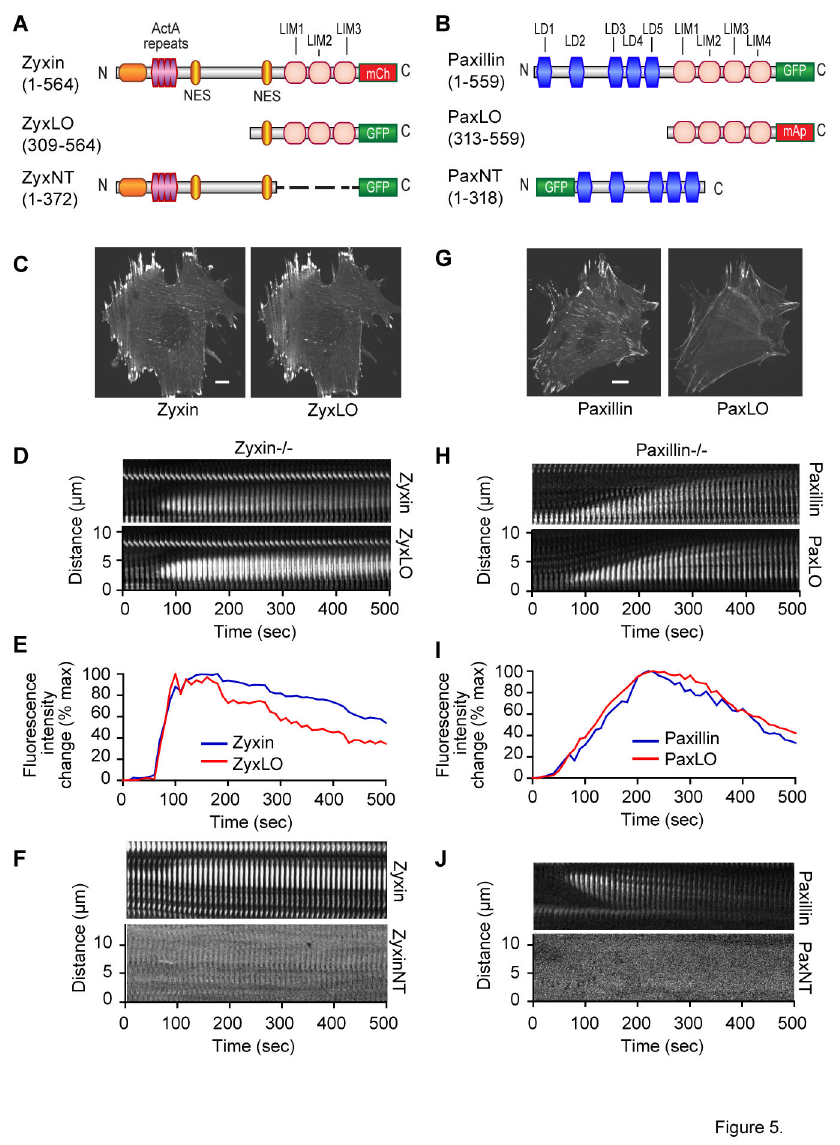
Figure 5. The LIM domains of paxillin and zyxin are necessary and sufficient for recruitment to SFSS. We generated GFP tagged truncated zyxin, ZyxLO (A) and mApple tagged truncated paxillin, PaxLO (B), containing the LIM domains of each protein. ZyxLO was expressed in zyxin-/- cells along with full length zyxin-mCherry (C). Time lapse imaging of ZyxLO and full-length zyxin with kymograph analysis (D) and average SFSS fluorescent intensity/time (E), show ZyxLO was recruited to SFSS in synchrony with full length zyxin. LIM-domain deleted N-terminal mutant zyxin, ZyxNT (A), did not show any strain site localization (F). PaxLO was expressed in paxillin-/- cells, along with full length paxillin-GFP. When compared to full length paxillin, PaxLO localized less to focal adhesions, and was significantly more concentrated on stress fibers (G). PaxLO was recruited to stress fibers along with paxillin (H and I). LIM-domain deleted PaxNT showed no strain site localization (J). Scale bar=10um.